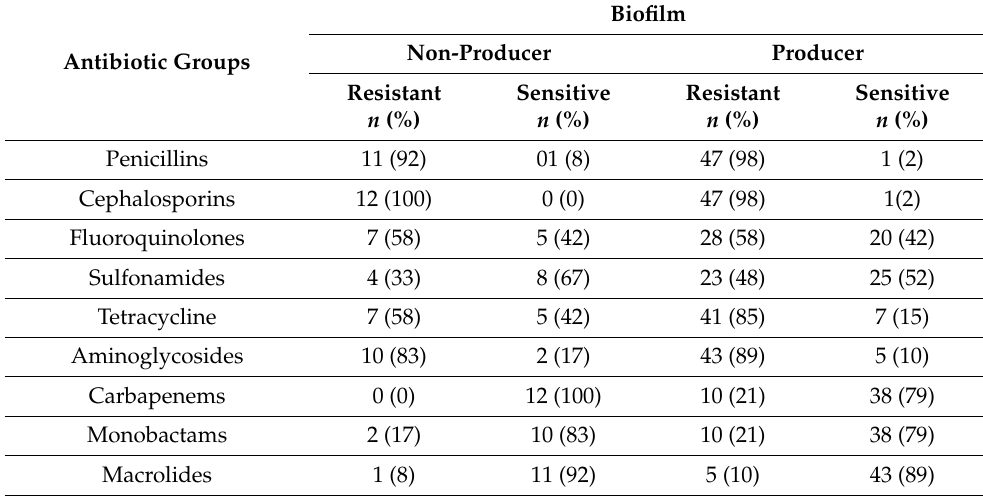
Table 3. Association of biofilm production with antibiotic resistance.